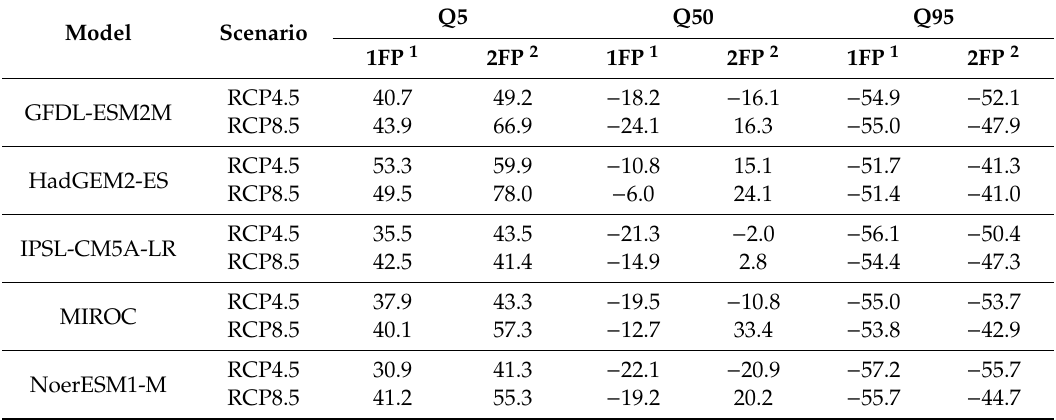
Table 6. Relative changes in extreme (high and low) flows, as well as median flow, under the RCP4.5 and RCP8.5 scenarios in the Vakhsh River Basin, Central